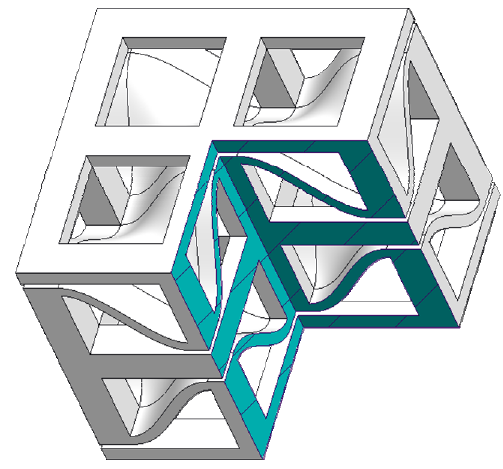
Figure 1. CAD model of the structure with a 3D cross section the DoE. This allows to extract an experimental